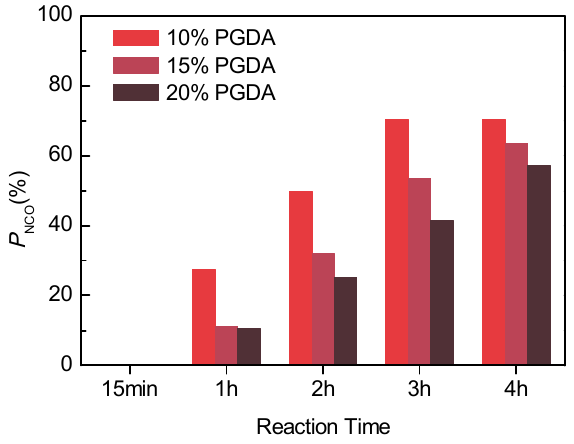
Figure 4. Extent of NCO reaction during the curing process of waterborne polyurethane coating (10%, 15%, 20% PGDA).